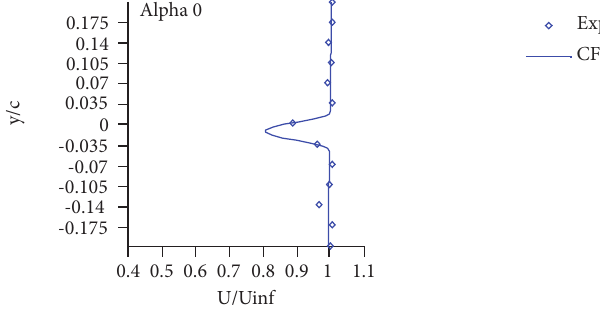
Figure 26. Streamwise velocity profile at x/c = 0.5, Mach = 0.4.